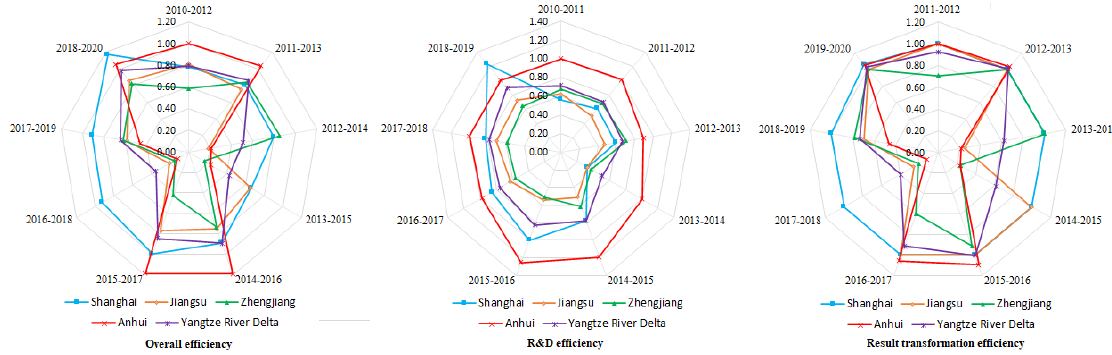
Figure 4. Distribution of the Efficiency by Provinces in YRD region.